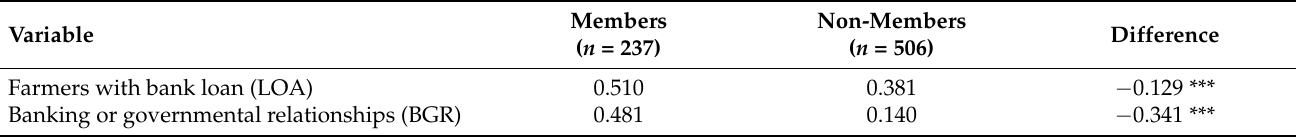
Table 2. Average difference between cooperative members and